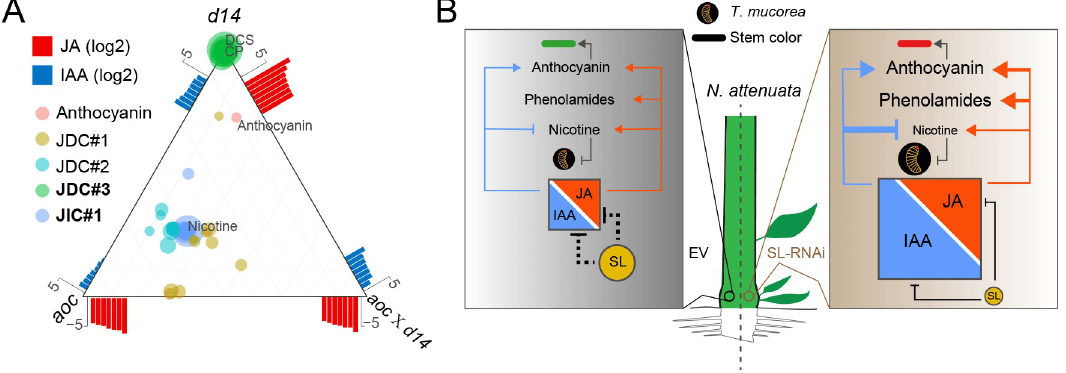
Fig 9. SL signaling regulates anthocyanin accumulations and plant defense against T . mucorea larval attack via its interaction with JA and auxin signaling. (A) A ternary analysis illustrating metabolite distributions across three genotypes: aoc , d14 , and aoc × d14 plants. For JIC#1 and JDC#1–3, see Fig 4 and S6 Fig. (B) A model of the role of SLs as regulators that fine-tune resistance to endophytic stem-feeding weevils by disrupting the SL-mediated homeostasis between auxin and JA signaling. In N . attenuata , SL- deficient ( d14 , max2 , and ccd7 ) plants produce more branches (right panel) relative to EV (left panel), have lower pith nicotine levels and higher anthocyanin and phenolamine levels, and are more susceptible to T . mucorea attack. In EV plants, SL levels maintain auxin and JA homeostasis, but once SL signaling is impaired, auxin and JA levels increase and become unbalanced, decreasing pith nicotine levels and increasing susceptibility to larval attack. Values for the graph (A) are listed in S1 Data. aoc, allene oxide cyclase; CP, N 0 -caffeoylputrescine; d14, dwarf14; DCS, N 0 , N @ -decaffeospermidine; EV, empty vector; JA, jasmonate; IAA, indole-3-acetic acid; JDC, JA-dependent cluster; JIC, JA-independent cluster; max2, more axillary growth 2; SL, strigolactone.